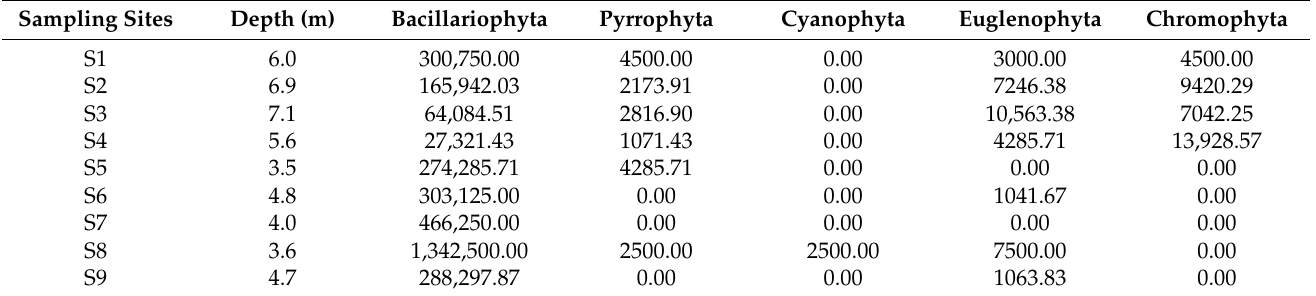
Table 2. Spatial distribution of phytoplankton abundance in the waters around Macau (cells/m 3 ).